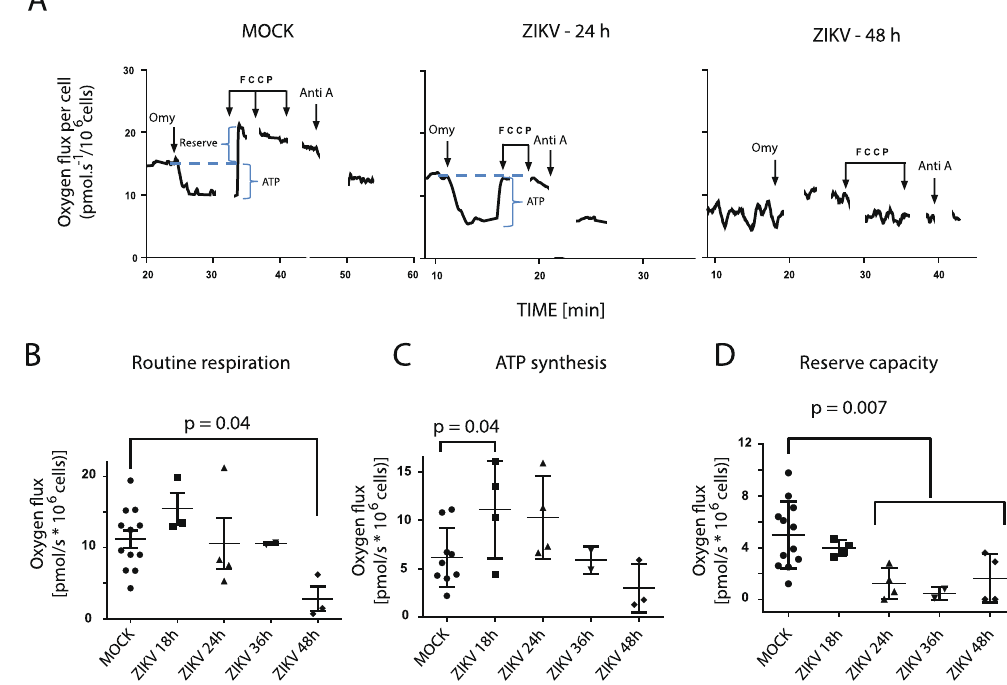
Figure 2. ZIKV-induced mitochondrial dysfunction. ( A ) Respirometry analysis of MOCK or ZIKV-infected astrocytes after 24 and 48 hpi. ( B ) Routine respiration, ( C ) ATP synthesis, ( D ) Reserve capacity of infected astrocytes at different time points post infection. N = 12 for MOCK and N = 3 for each time point of ZIKV infection. Astrocyte lines used were derived from iPSC lines GM23279A, C15, CF1 and